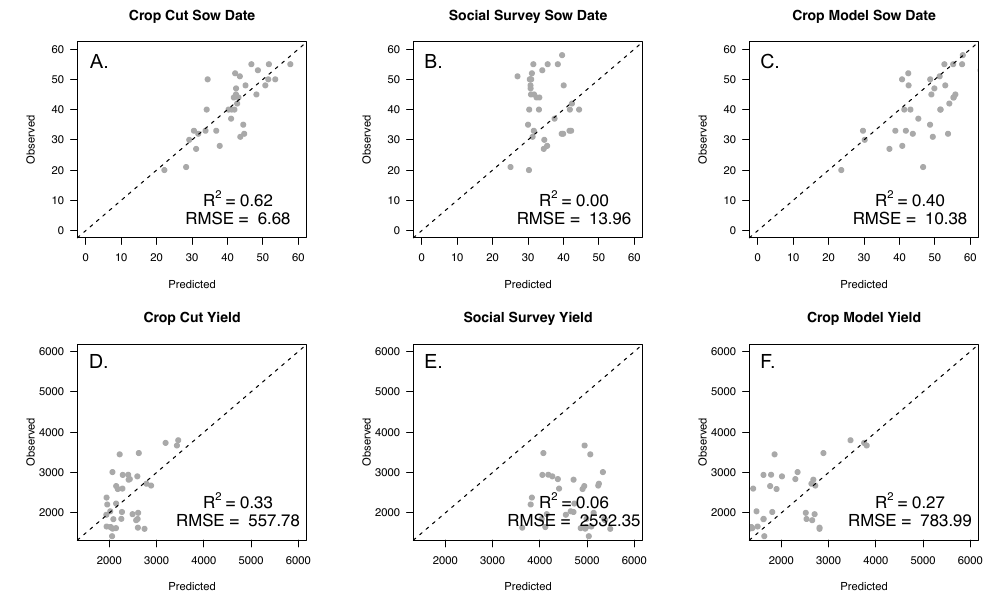
Figure 5. Sow date and yield prediction accuracies using 2015–2016 imagery. Predicted versus observed sow dates using: the crop cut parameterized model ( A ); the self-report parameterized model ( B ); and the crop model parameterized model ( C ). Predicted versus observed yields using: the crop cut parameterized model ( D ); the self-report parameterized model ( E ); and the crop model parameterized model ( F ). The one to one line is highlighted with a dashed line, and R 2 and RMSE for each analysis are